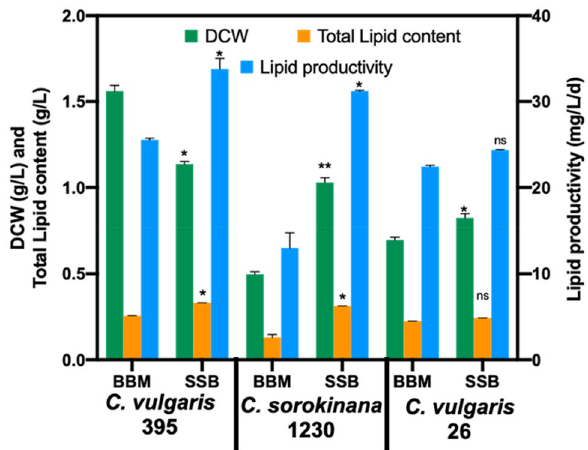
Figure 1. Dry cell weight (DCW), total lipid content, and total lipid productivity of Chlorella 395, Chlorella 1230, and Chlorella 26 on the 10th day of batch cultivation in BBM medium (BBM) vs. SSB hydrolysate (SBB). (* p < 0.05; ** p < 0.01; ns: not